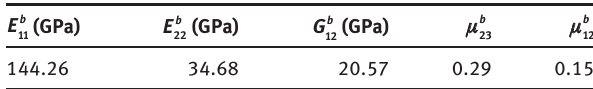
Table 3: Elastic parameters of the fiber